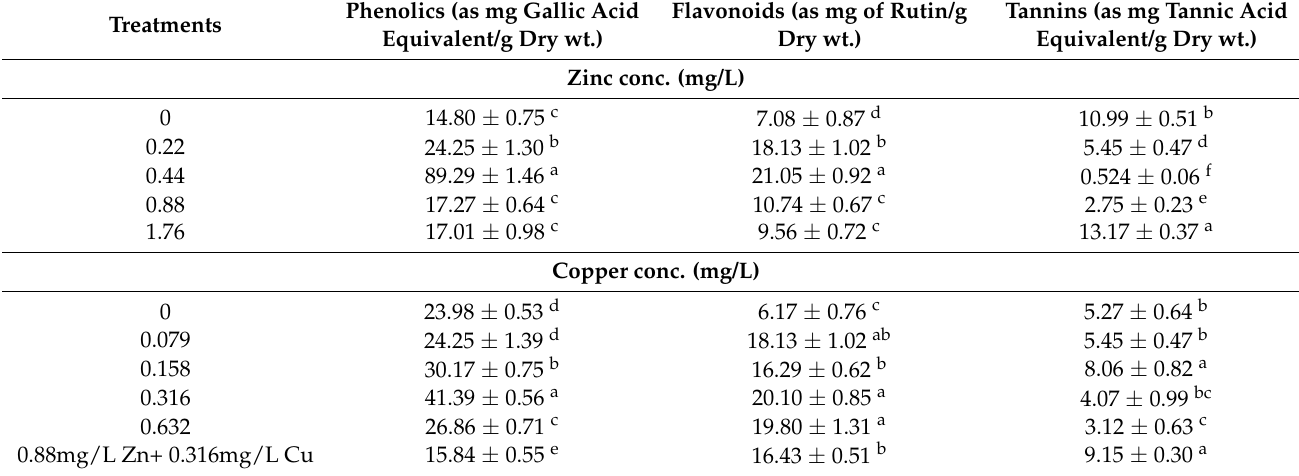
Table 7. Phenolic, flavonoids and tannins content of Nostoc linckia cultured on different concentration of zinc and copper (and in combination).